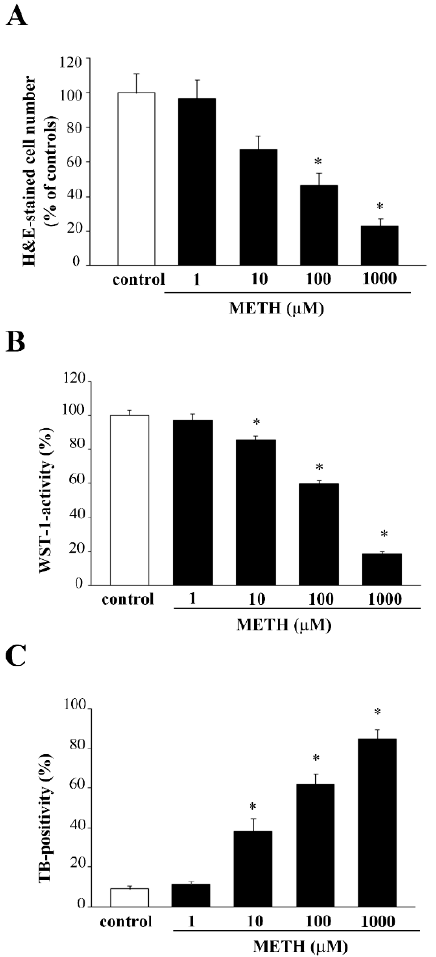
Figure 7. METH dose-dependently affects PC12 cell survival. PC12 cell survival decreases after increasing doses of METH (1 µ M, 10 µ M, 100 µ M, 1000 µ M) for 72 h dose-dependently. Cell viability was evaluated with ( A ) H&E staining, ( B ) WST-1 activity ( C ) TB-positivity. * p ≤ 0.05 compared with